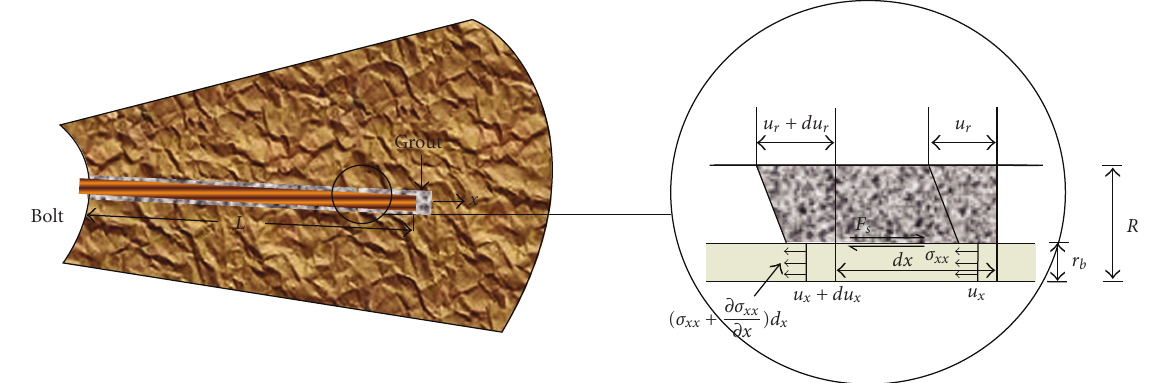
Figure 3: Stress component along a fully grouted